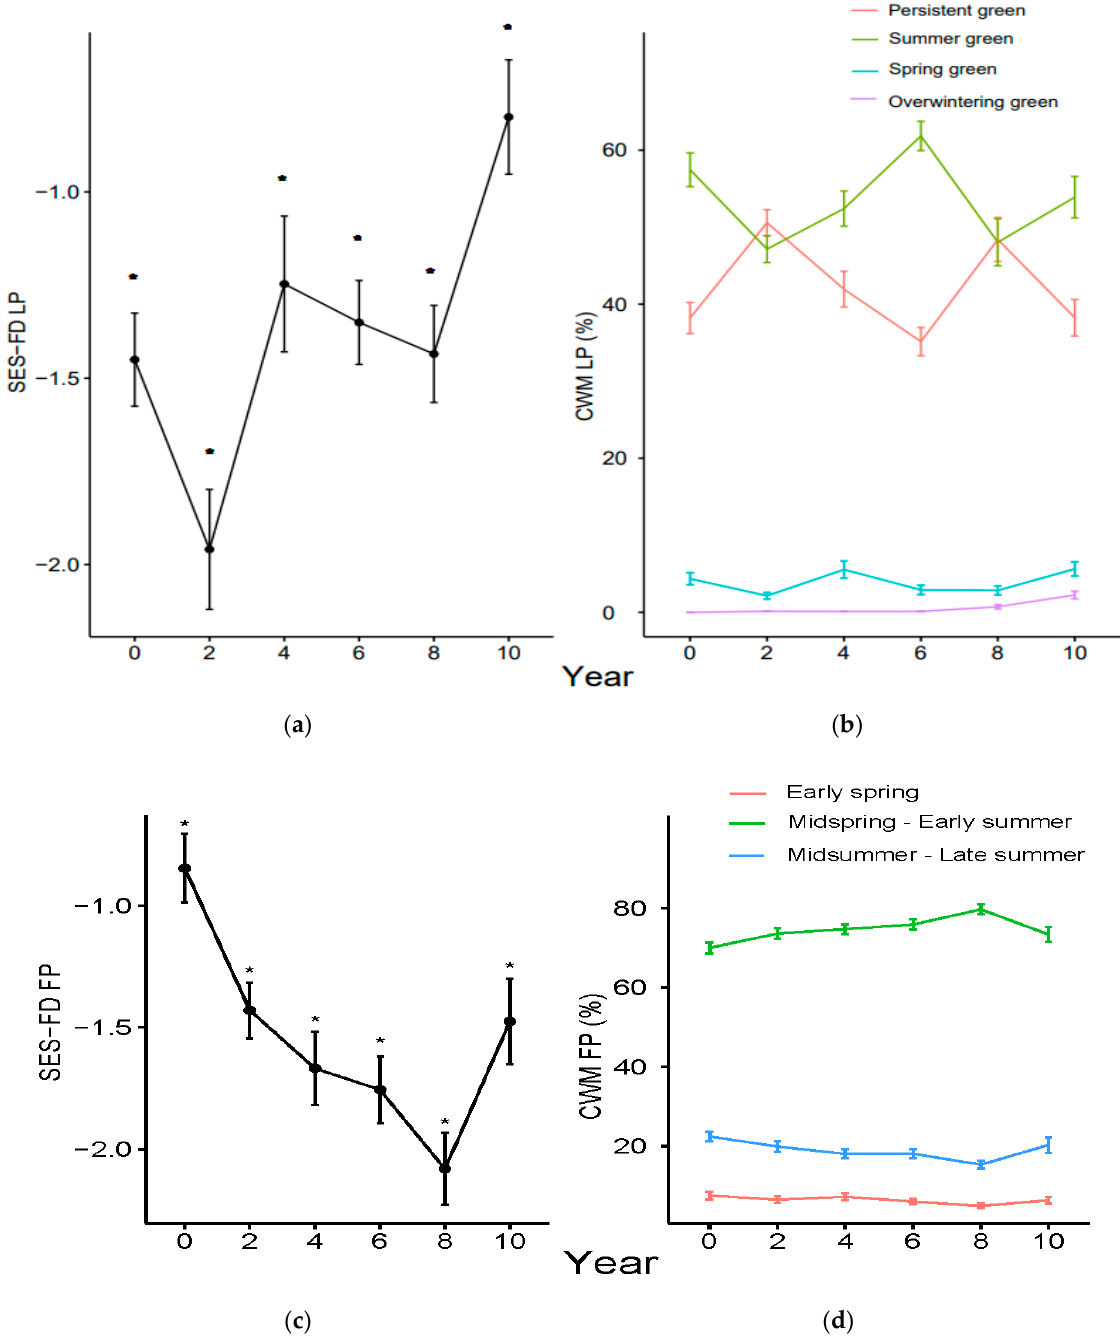
Figure 4. Trends of standardized effect size of functional diversity (SES-FD) and community weighted means (CWMs) (mean ± s.e.) for phenological traits; ( a , b ) leaf phenology (LP), ( c , d ) flower phenology (FP) under twice-a-year mowing. Year 0 (before treatment) refers to 2010; years 2, 4, 6, 8, and 10 correspond to 2012, 2014, 2016, 2018, and 2020. The asterisk ( * ) indicates a distribution of SES-FD significantly different from zero after a one-sample two-tailed t -test ( p < 0.05).